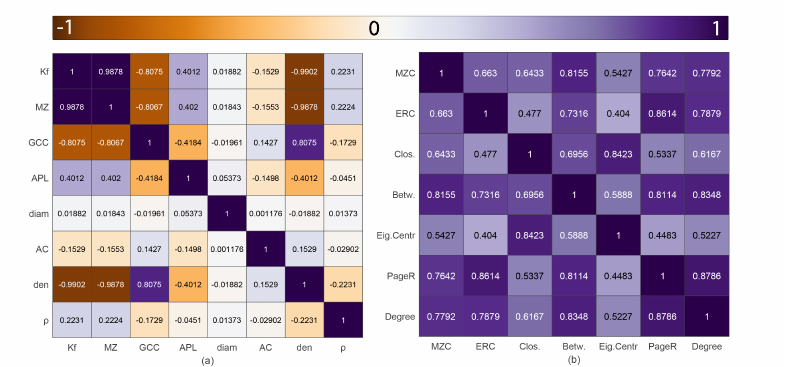
Figure 8. ( a ) The correlation between the global graph measures for more than 10 3 graphs generated by the Barabási − Albert scale − free model with | V | ∈ [ 1500,2500 ] , m 0 = 5 and m = 4. ( b ) The correlation between the local measures of each vertex of the graph generated by the Barabási − Albert scale − free model with | V | = 2500, m 0 = 5 and m =